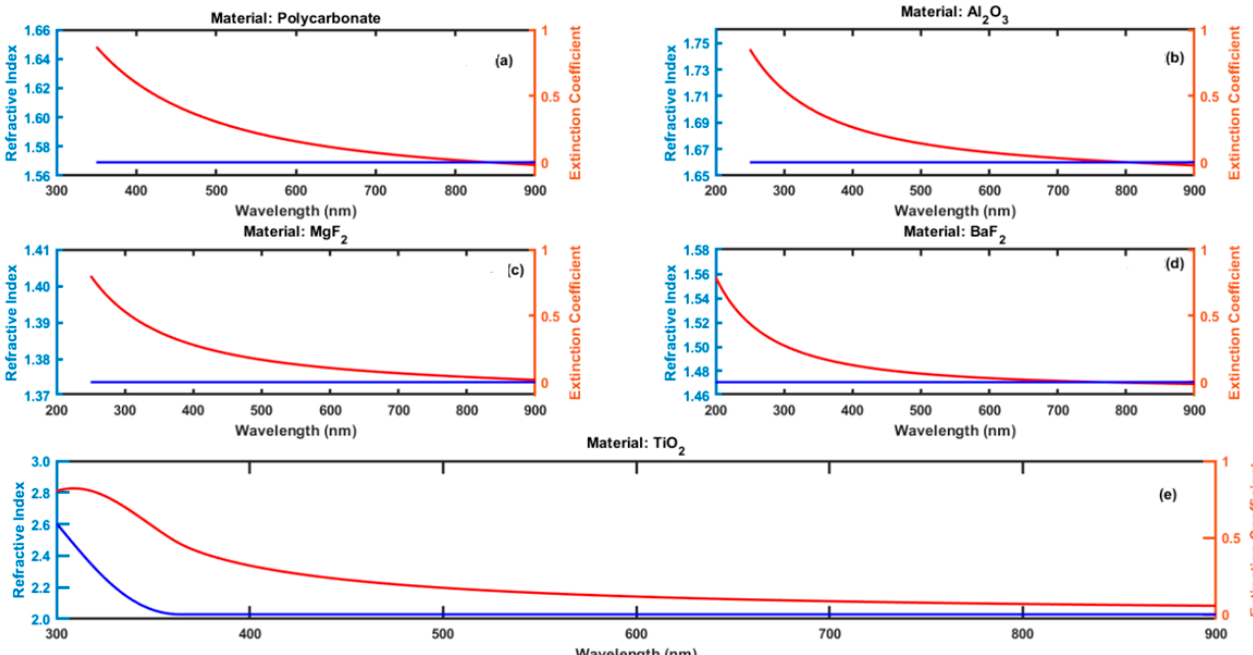
Figure 3. The wavelength-dependent refractive index and extinction coefficient of polycarbonate, Al 2 O 3 , MgF 2 , BaF 2 and TiO 2 materials are in ( a – e ), respectively. Here, red and blue solid lines are used to represent the refractive index and extinction coefficient of the respective materials.